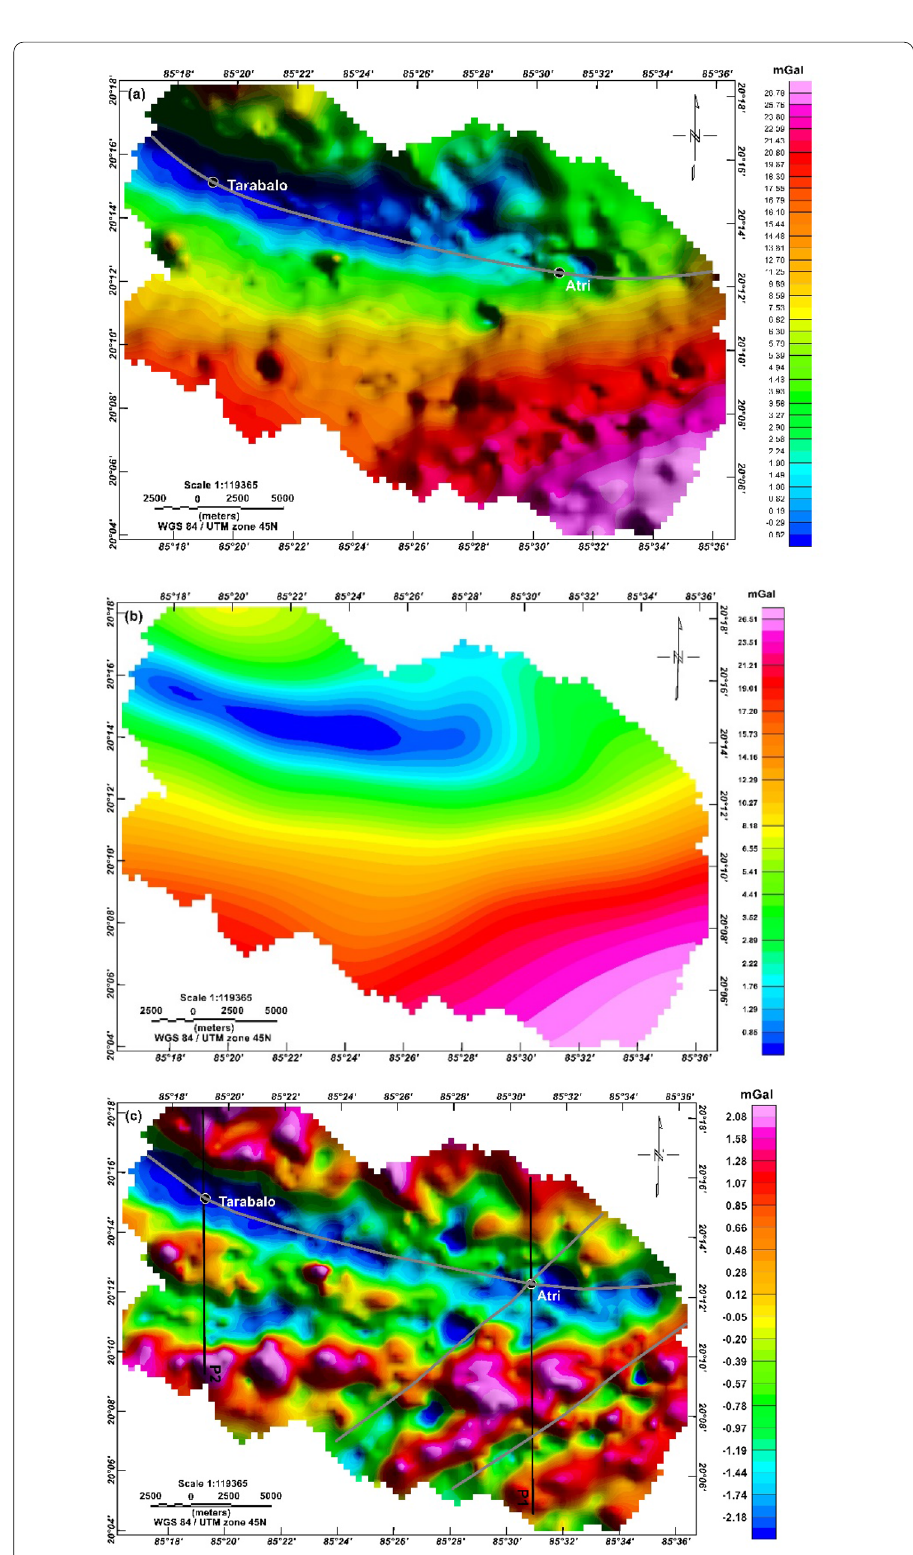
Fig. 3 Land gravity anomaly maps of the surveyed area: a Bouguer anomaly, b regional anomaly, and c residual anomaly. P1 and P2 are two profiles for forward and inverse residual gravity modelling. Grey lines indicate the location of the faults in the